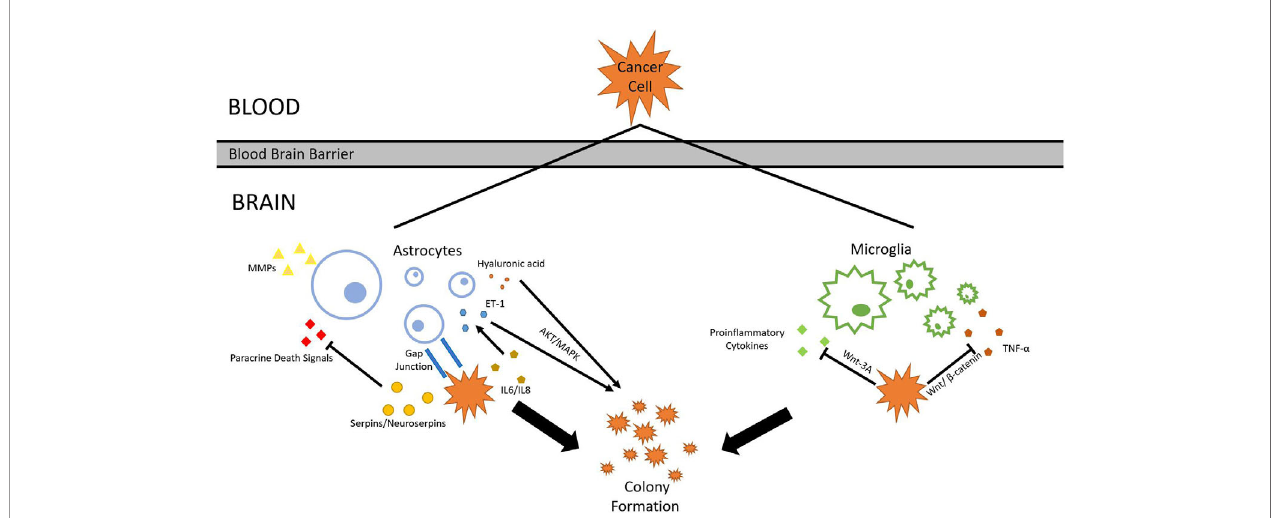
FIGURE 3 | Astrocyte and microglia. To survive and colonize the brain, lung cancer cells must interact with surrounding glial cells such as astrocytes and microglia. Through various mechanisms, cancer cells are able to withstand the threats and cooperate with glial